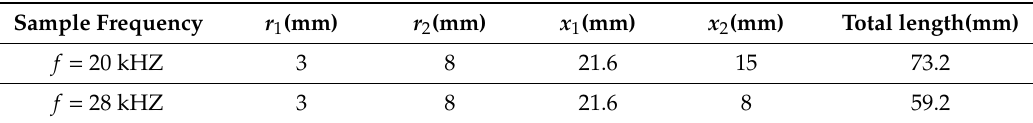
Figure 4. Connecting structure diagram of the sample and tail horn.